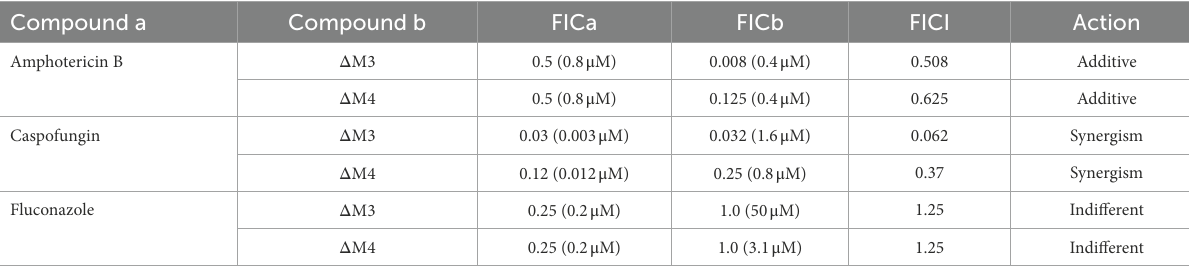
TABLE 3 Combined antifungal activity of Δ M3 and Δ M4 with conventional antifungals. Compound